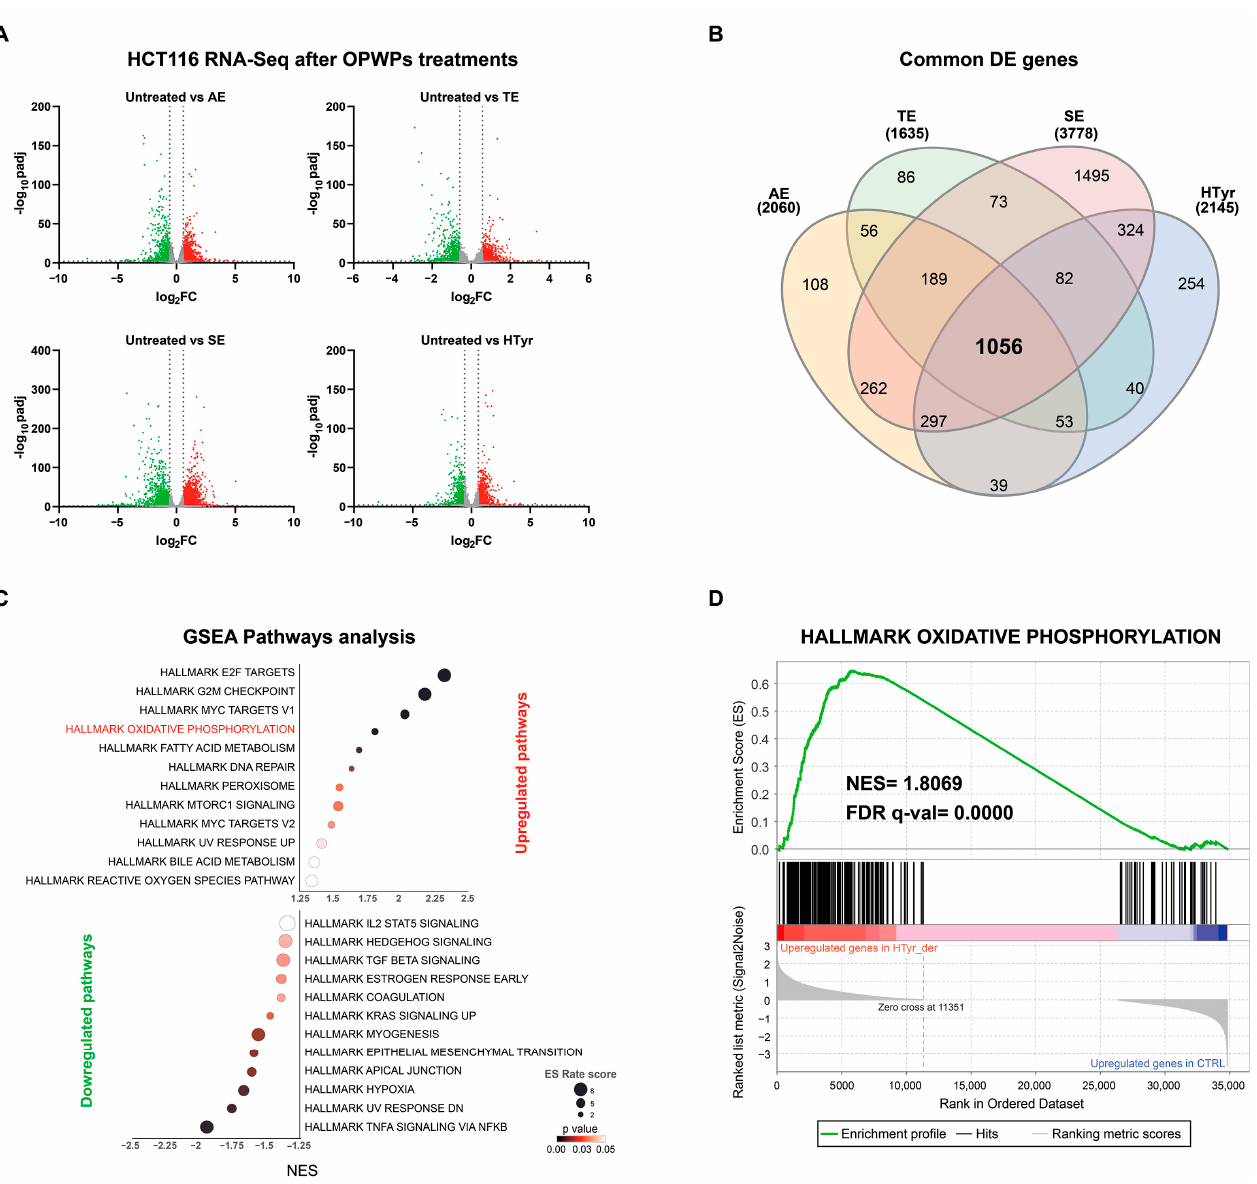
Figure 1. RNA-Seq analysis on HCT116 cells untreated or treated with HTyr or the OPWPs extracts. ( A ) RNA-Seq analysis was carried out on HCT116 cells treated or not with HTyr or selected OPWPs extracts, namely AE, TE, SE, respectively. The Volcano plots illustrate the Differentially Expressed Genes (DEGs) selected by applying a p adj < 0.05 and Log 2 FC > 0.585 or Log 2 FC < − 0.585. ( B ) The Venn Diagram shows the common DEGs after treatments, out of which 571 were upregulated and 485 downregulated. GSEA analysis was performed on DEGs and HALLMARK (h.all.v2022.1) was used as reference geneset. ( C ) The Enrichment Score (ES) and Normalized Enrichment Score (NES) were used to generate a ranking of the top inferred pathways. OXPHOS emerged as the fourth most influenced pathway by HTyr or OPWPs treatments. ( D ) The distribution plot depicts the enriched genes of the OXPHOS pathway, most of which were upregulated. The size of the dots is proportional to the number of overlapping genes.